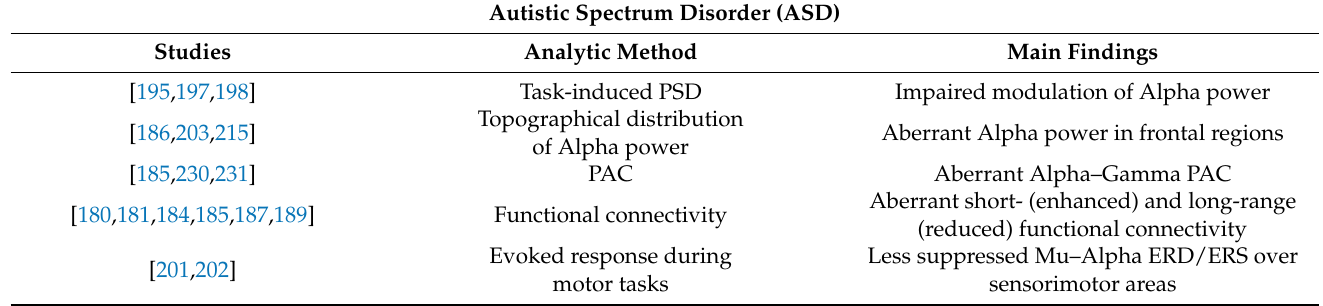
Table 4. Table representing the main electrophysiological findings in the ASD, with the methods and the studies who contributed to